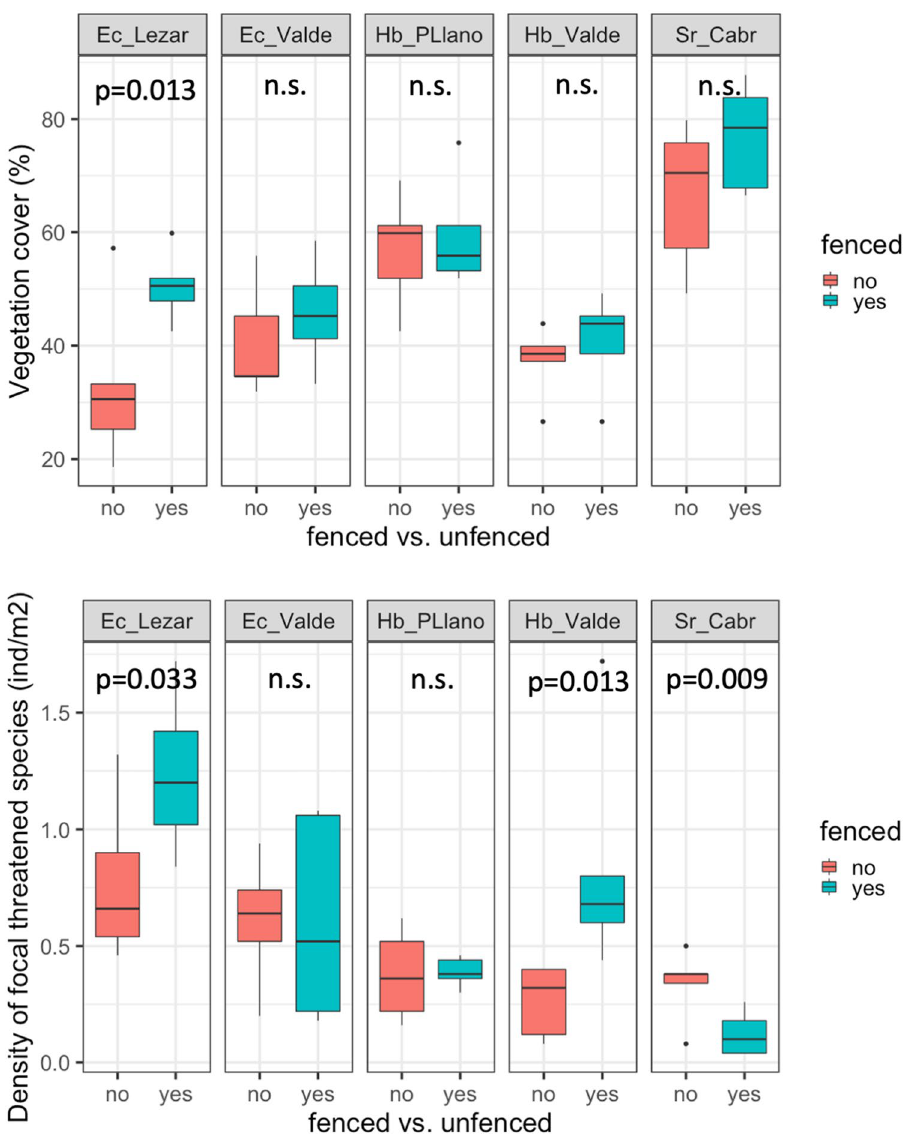
Figure 2. Boxplot for cover (top graphs) and density (bottom graphs) of fenced and unfenced habitat patches for all the studied populations (see Table S1). P values indicated for each pair comparison were obtained after permutational ANOVA. Abbreviations for species and populations: Ec_Lezar Erodium cazorlanum -Puerto de Lezar, Ec_Valde Erodium cazorlanum -Valdeazores, Hb_PLlano Hormathophylla baetica -Puerto Llano, Hb_Valde Hormathophylla baetica -Valdeazores, Sr_Cabr Solenanthus reverchonii -Cabrilla